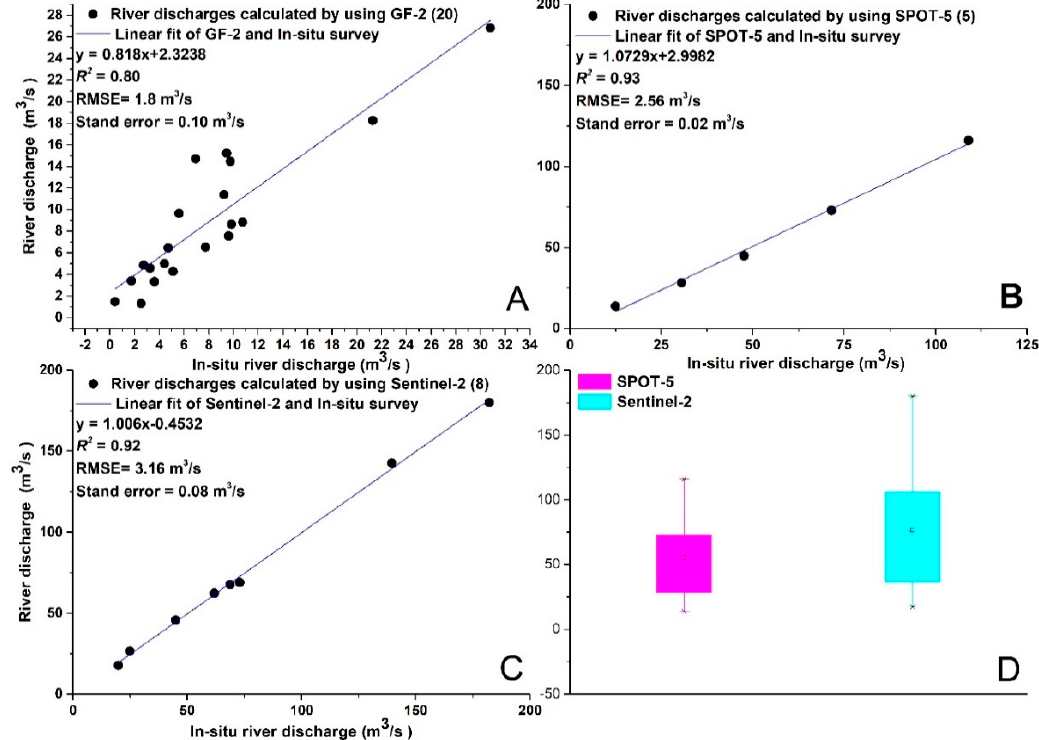
Figure 7. Comparison of the river discharges from the GF-2, SPOT-5, and Sentinel-2. ( A ): Performance of the GF-2 for calculating the river discharge; ( B ): Performance of the SPOT-5 for calculating the river discharge; ( C ): Performance of the Sentinel-2 for calculating the river discharge; ( D ): Comparison of the river discharges from the SPOT-5 and Sentinel-2.